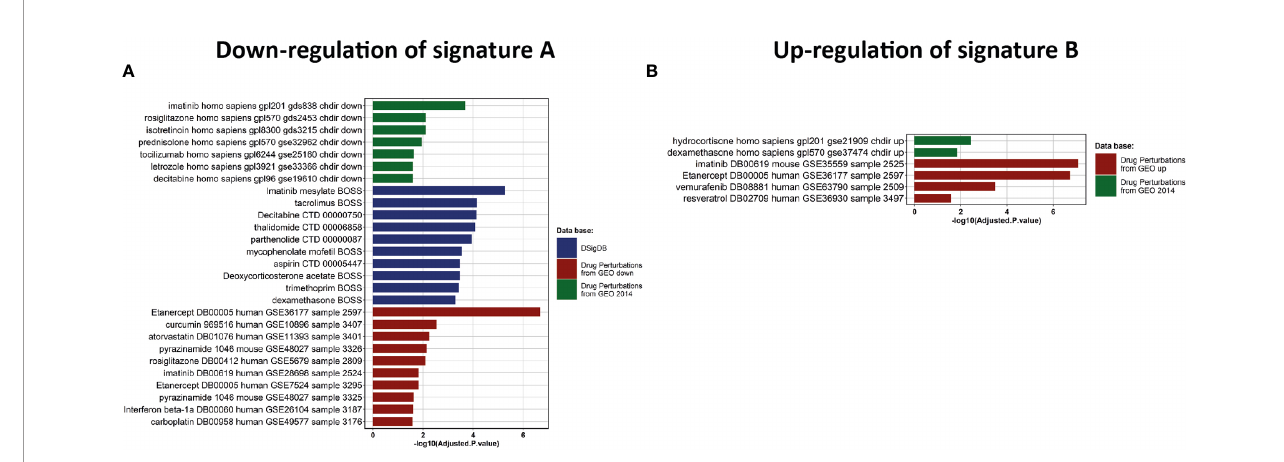
FIGURE 5 | Drug discovery and clinical assays. (A, B) Enrichment analysis of drug signatures from DsigDB and GEO drug perturbations to down-regulate Signature A or up-regulate signature B,